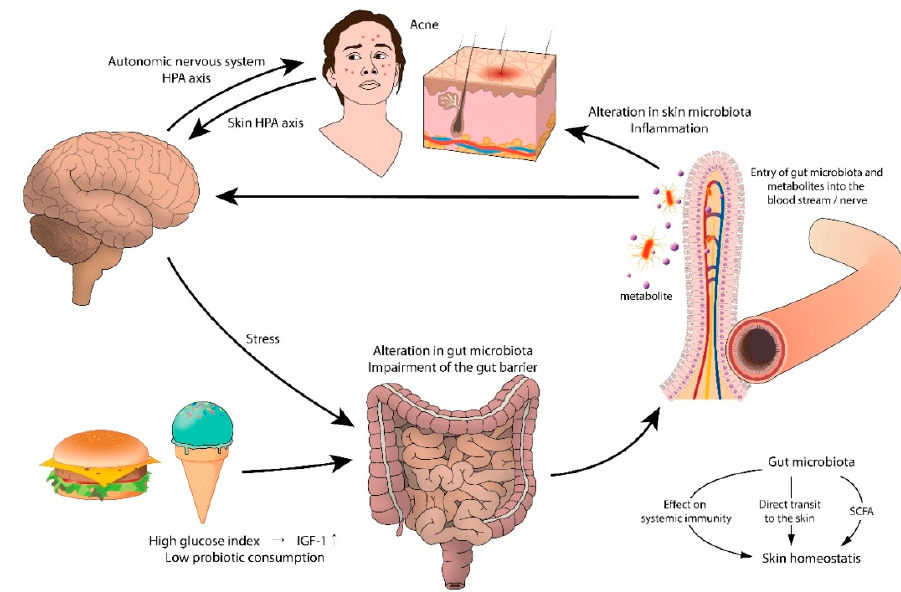
Figure 5. A proposed model of the gut–brain–skin axis in acne. HPA: hypothalamic pituitary adrenal; IGF-1: Insulin-like growth factor-1; SCFA: short chain fatty acid.